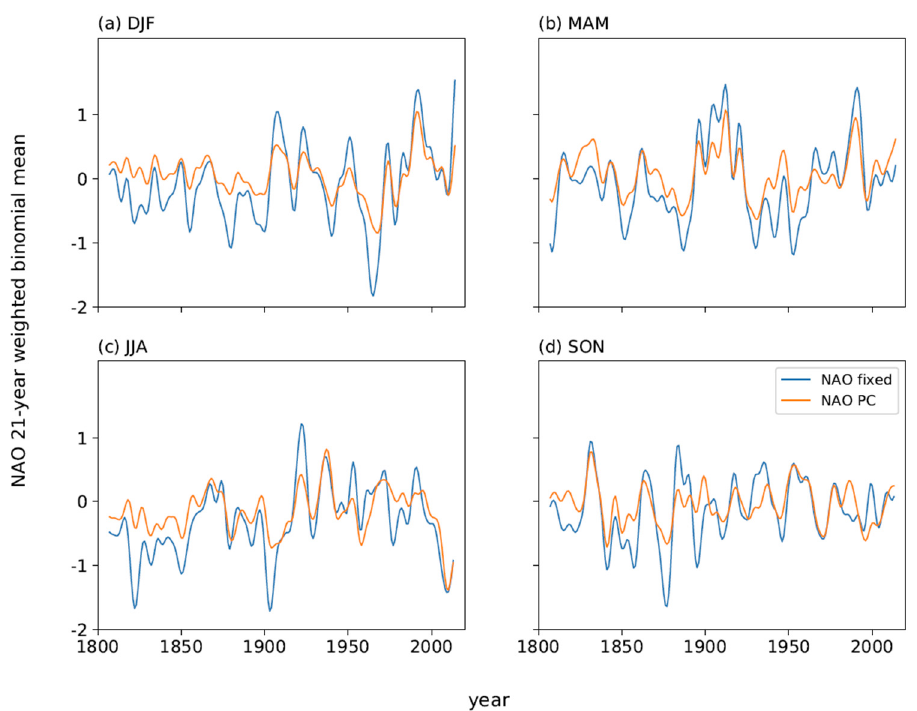
Figure 9. Smoothed seasonal series of NAO Fixed and NAO PC for ( a ) winter (DJF); ( b ) spring (MAM); ( c ) summer (JJA); ( d ) autumn (SON). NAO yearly values have here been filtered using a 21-point binomial filter to emphasize any long-term fluctuations and trends. Table 4. Detrended correlation coefficients between seasonal GB 1 and NAO indices for various periods. Shaded values are *not* statistically significant at the p ≤ 0.05 level. Period DJF MAM JJA SON GB 1 , NAO